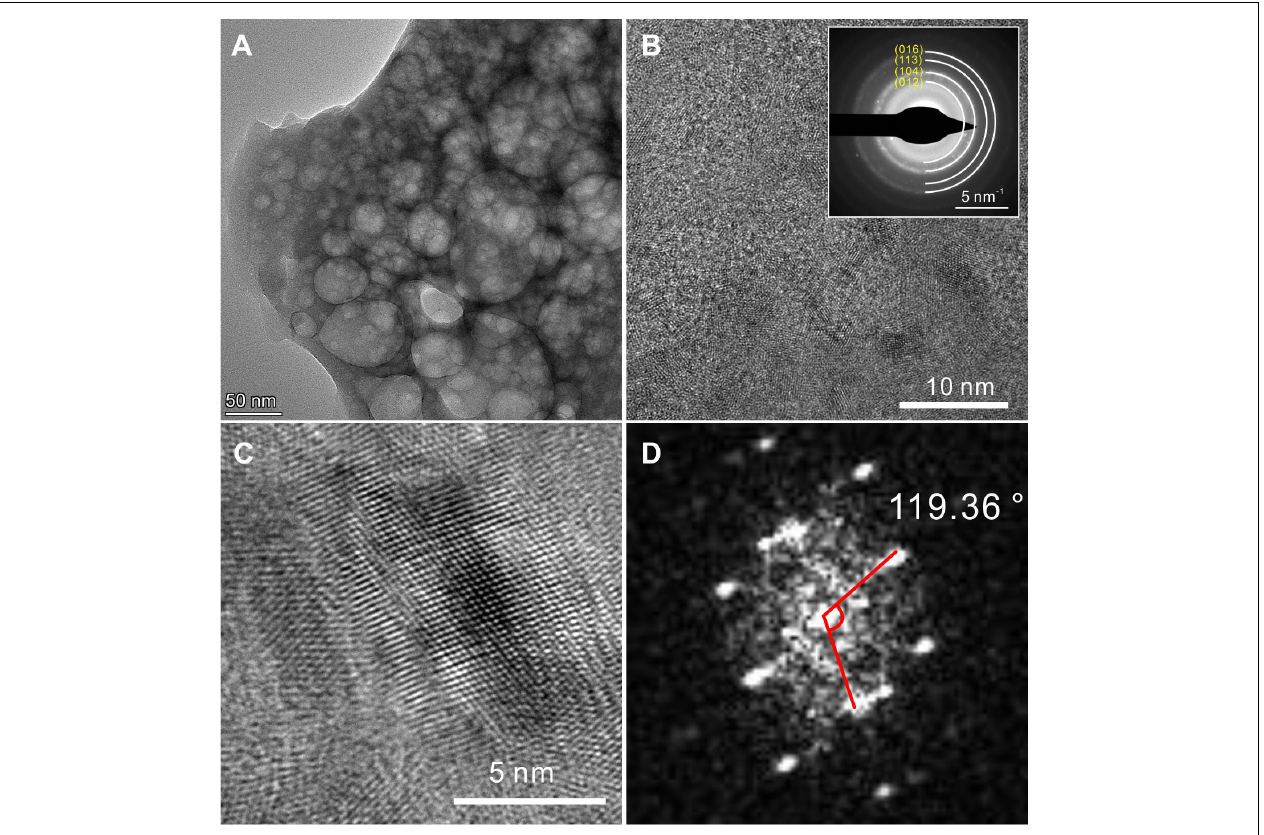
FIGURE 9 | TEM images of protodolomite induced by Vibrio harveyi QPL2. (A) A bright-field image of dolomite particles. (B) The SAED pattern shows diffraction rings of dolomite polycrystals and does not show any super-lattice structure. (C,D) The high-resolution image of a selected area and its FFT